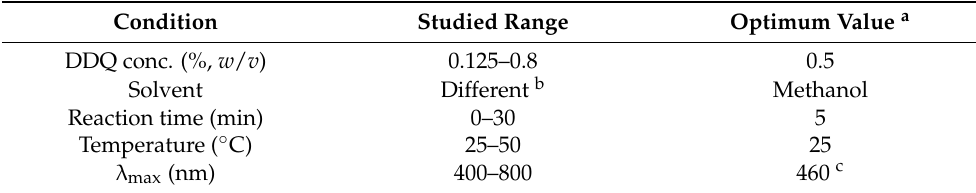
Table 1. Optimization of conditions for the MW-SPM for DUV and SEL based on their formation of colored CT complexes with DDQ.